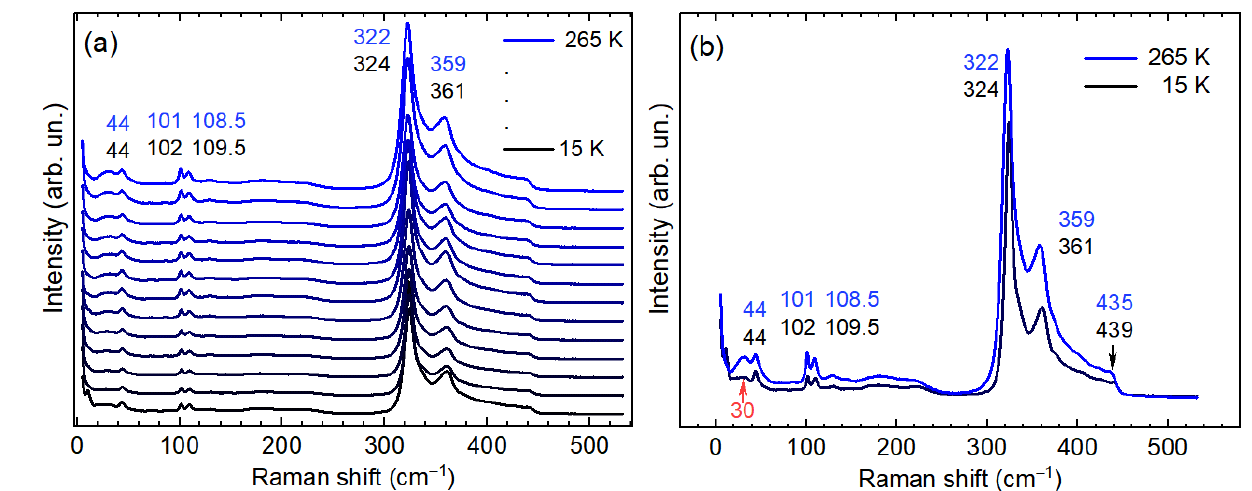
Figure 4. ( a ) Temperature-dependent Raman spectra of AgGaGeS 4 ( λ exc = 514.5 nm) in the range of 15 K to 265 K. ( b ) The spectra for 15 K to 265 K shown in more detail.